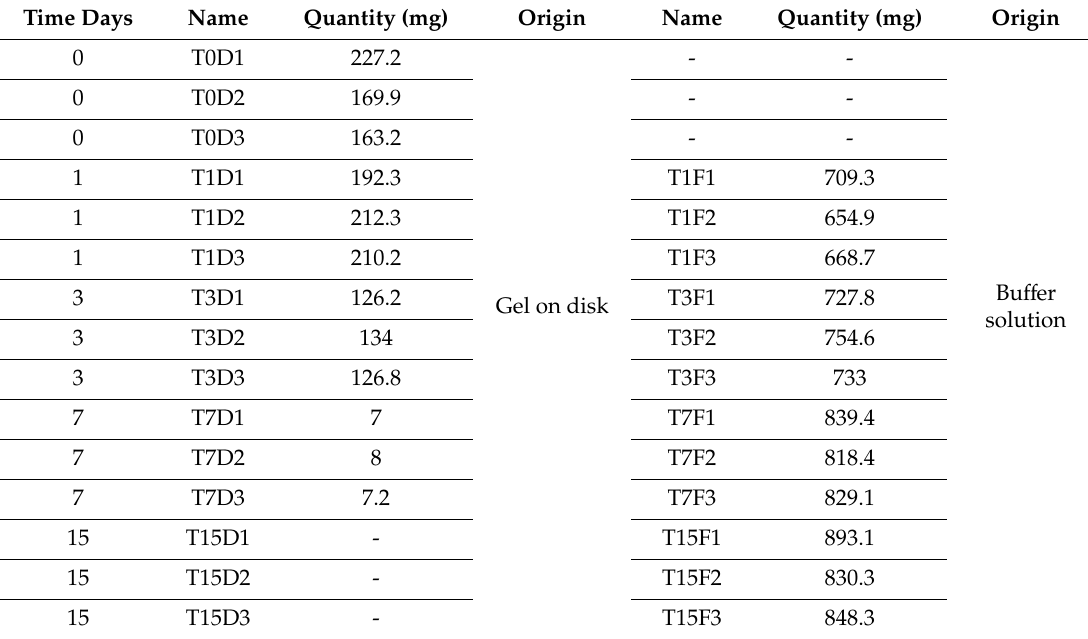
Table 1. The 24 samples of HA-PLA (Novagenit DAC ® ) recovered for HPLC and NMR study both from gel on disk and in bu ff er solution as indicated (see